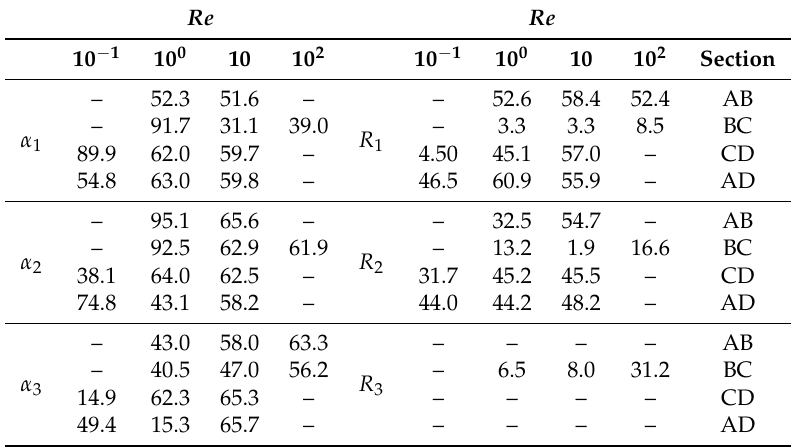
Table 4. Percentage error (%) between experimental and analytical data for pressure taps with sub-channel width w 2 = 108 µ m.